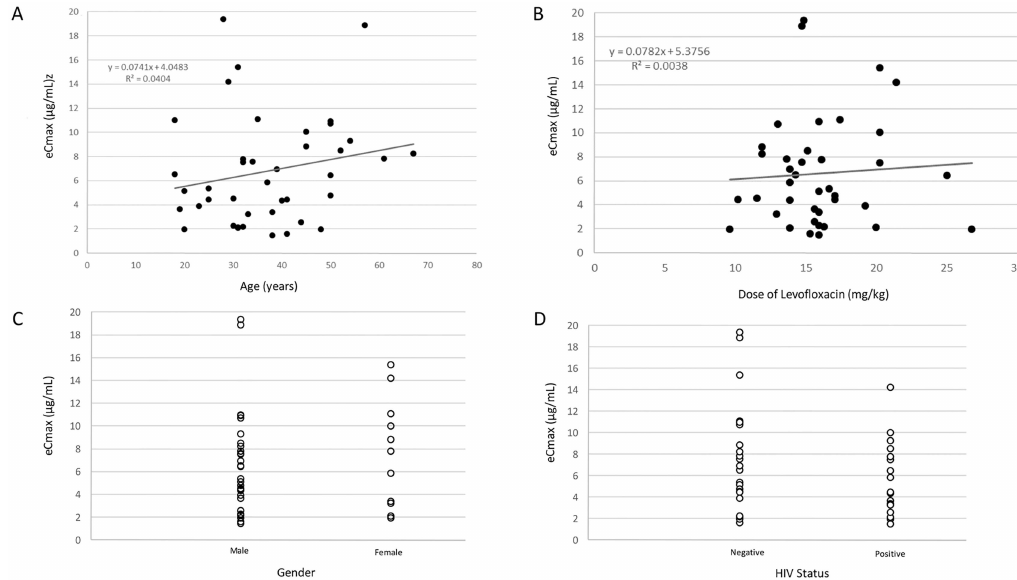
Fig 2. Distributions of plasma concentrations of levofloxacin by pretreatment characteristics. A) eCmax lack of correlationwith Age [R2 0.0404] B) eCmax lack of correlationwith mg/kg levofloxacindose [R2 0.0038] C) eCmax by Gender; mean eCmax for Males was 6.64 and Females 7.18, p = 0.74 D) eCmax by HIV Status; mean eCmax for those who were Positive was 5.94 and Negative7.35, p =